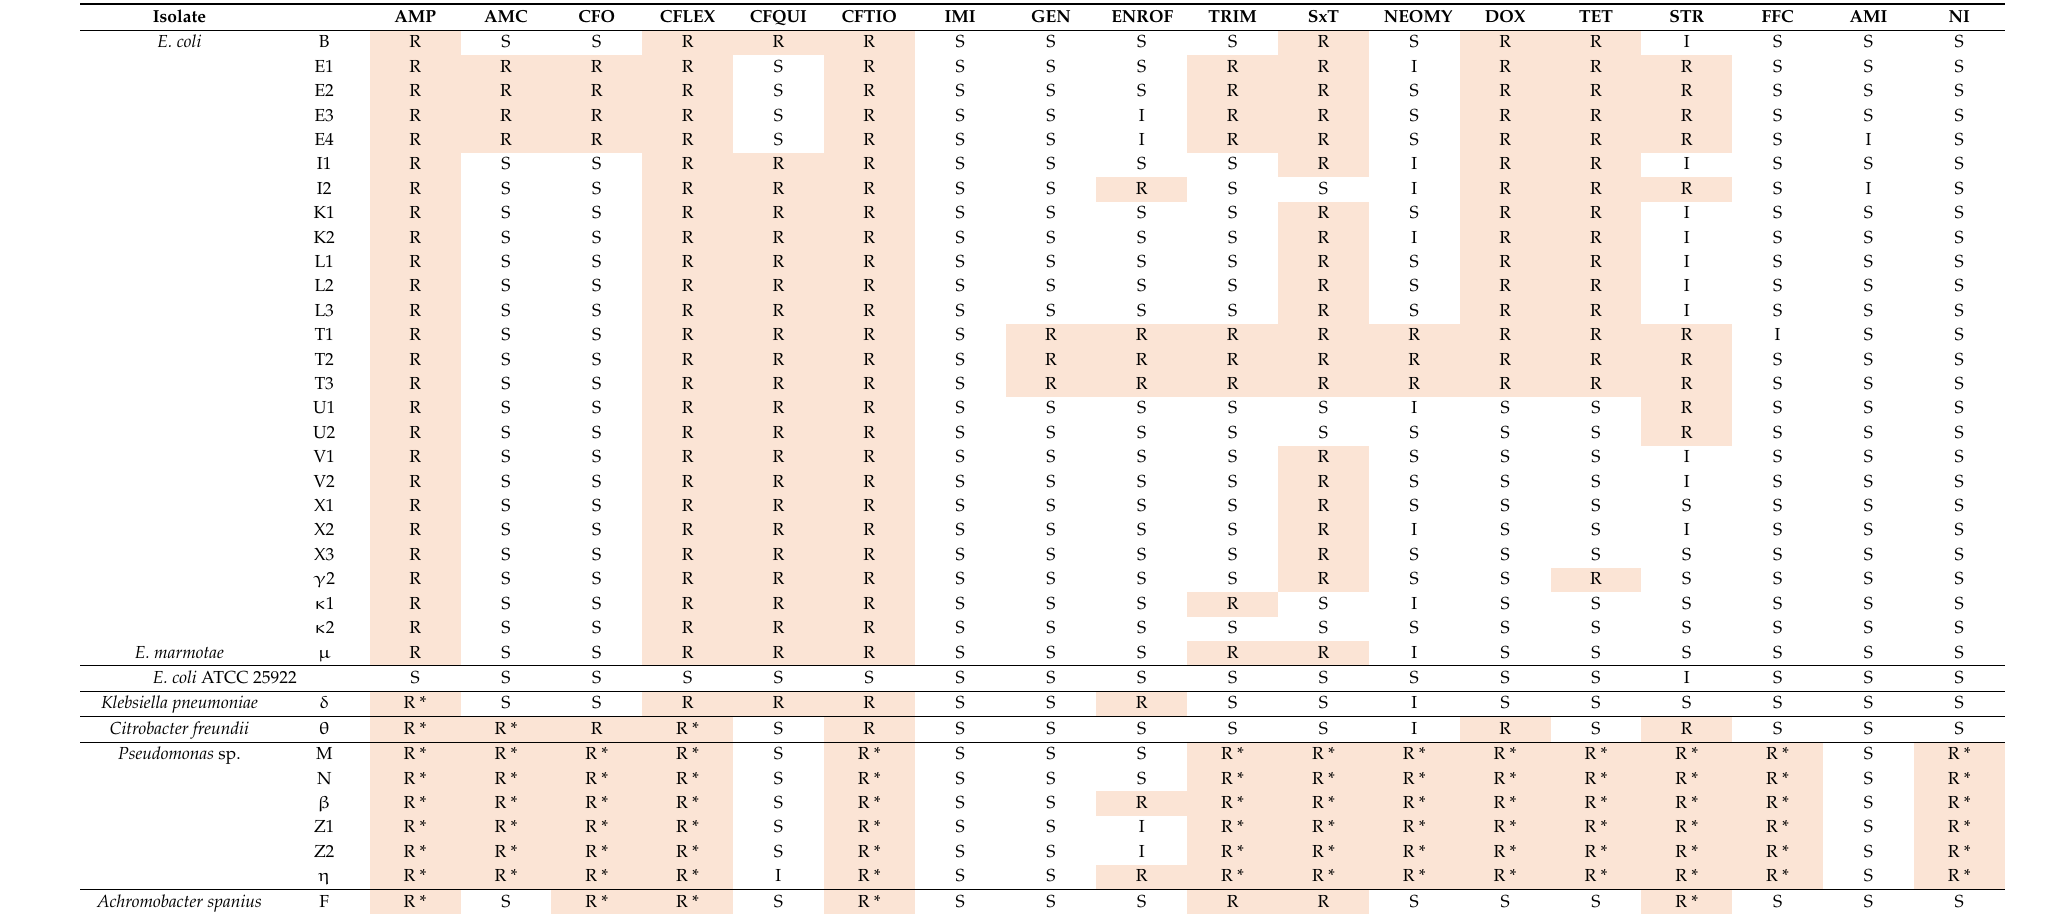
Table 2. Phenotypic resistance to β -lactam and non- β -lactam antimicrobials of 35 ceftiofur-resistant isolates obtained from zoo mammals. Isolate E.